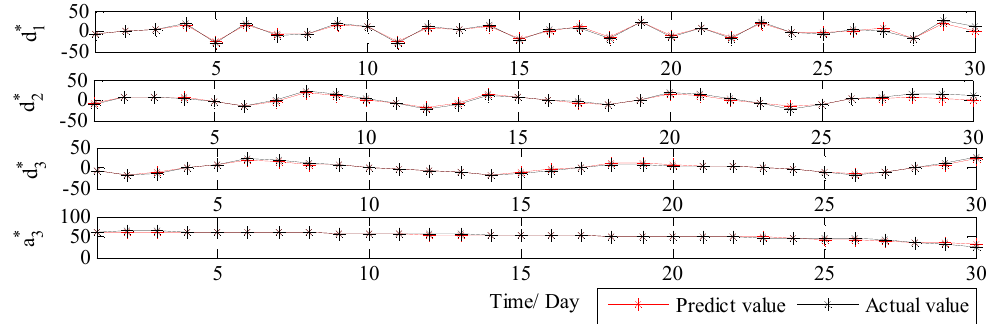
Figure 17. The forecast results of each subset by WT-VMD-DE-BP (Tianjin). Table 4. Comparison of prediction performances of different models (Tianjin).